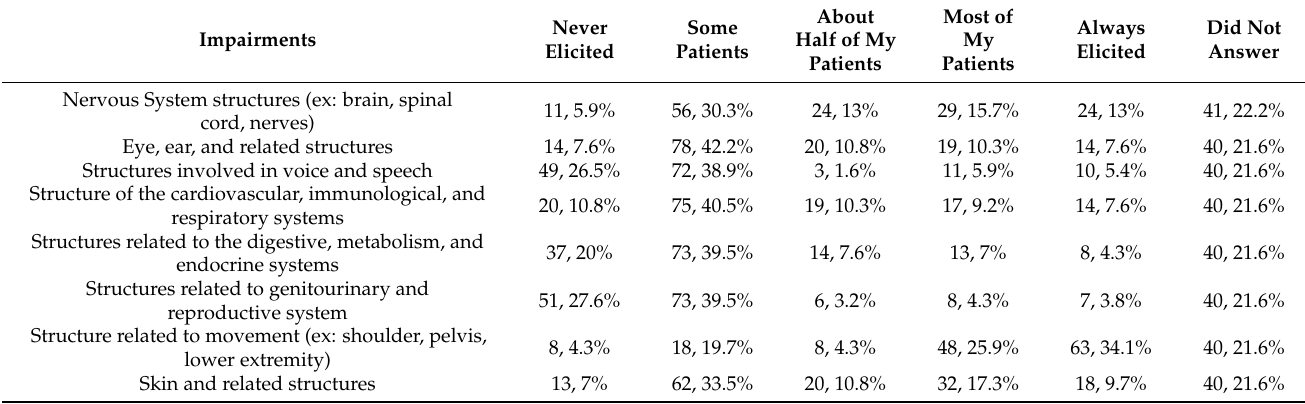
Table 6. Participant Report of Screening in Clinical Practice for Impairments of Body Structures ( n , %).